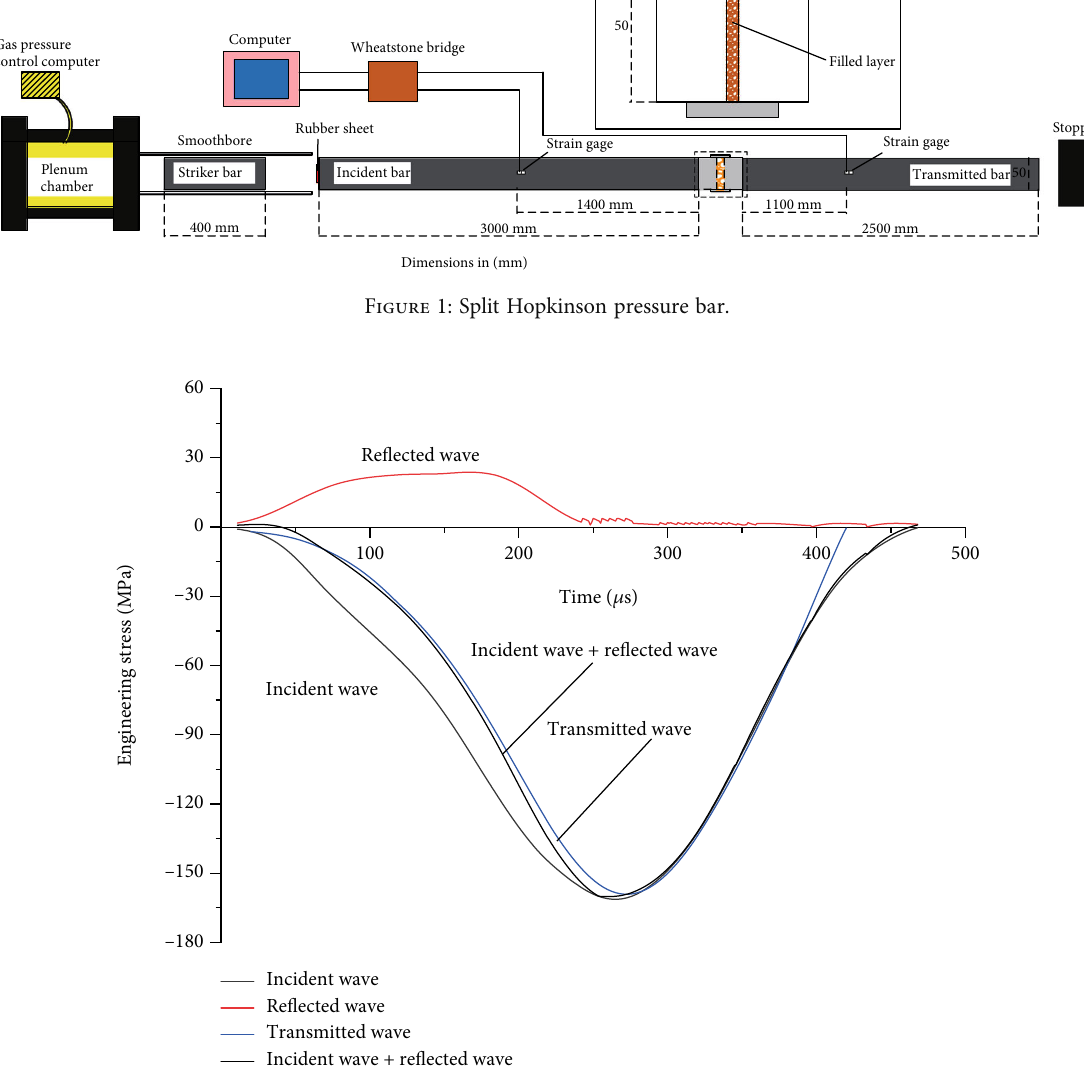
Figure 2: Typical response signals of incident, re fl ected, and transmitted